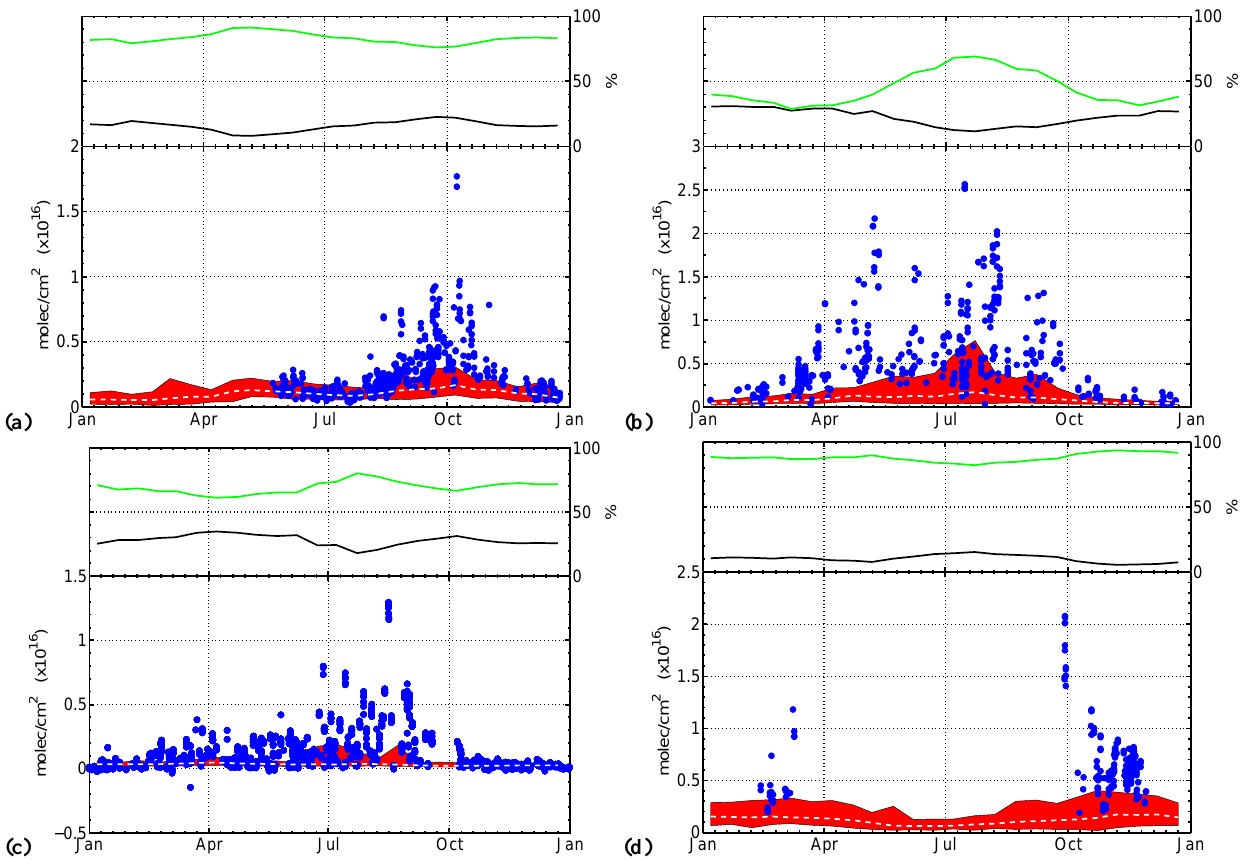
Fig. 4. (a) La R´eunion, France ( − 20.9 ◦ N, 55.5 ◦ E, 10m.as.l.). Measurements are from campaigns in 2004 (Aug–Oct), 2007 (May–June; Aug–Oct) and 2009 (May–Dec) and (b) Bremen, Germany (53.1 ◦ N, 8.9 ◦ E, 27ma.s.l.). Measurements are from 2002 to 2010. (c) Barcroft, United States (37.6 ◦ N, − 118.2 ◦ E, 3800ma.s.l.). Measurements are from campaigns in 1994 (Aug), 1998 (Oct–Dec), 1999 (Jan–Jul), 2000 (Oct–Dec), 2001 and 2002 (Jan-Aug) and (d) Paramaribo, Suriname (5.8 ◦ N–55.2 ◦ W, 23ma.s.l.). Measurements are from campaigns in 2004/2006 (Oct–Nov), 2005/2007 (Feb–Mar; Sep). Upper panels: same as Fig. 3. Lower panel: comparison between modeled and measured FA total columns. Individual total column measurements are indicated with blue dots. The 2004–2008 model range is indicated by the red shaded area and the model mean by the white dashed